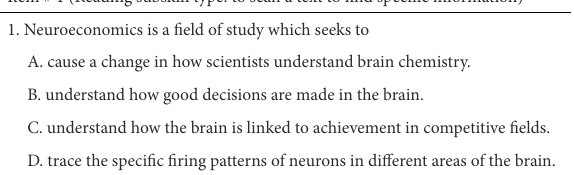
TABLE 3 Sample item from the reading comprehension test.